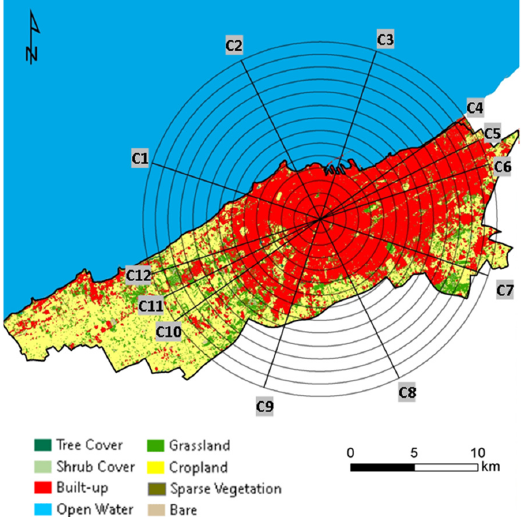
Figure 6. Land cover classification for the urban area of Casablanca (buffers shown every 1080 m).